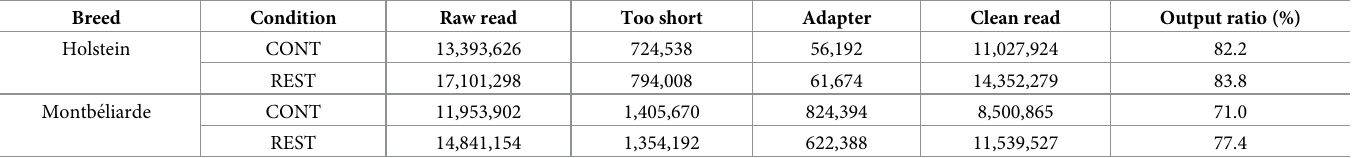
Table 2. Effect of feed restriction on miRNA RNA-seq data in mammary glands from midlactation Holstein (n = 5) and Montbe´liarde (n = 6) cows in control (CONT) and restriction (REST) periods. Breed